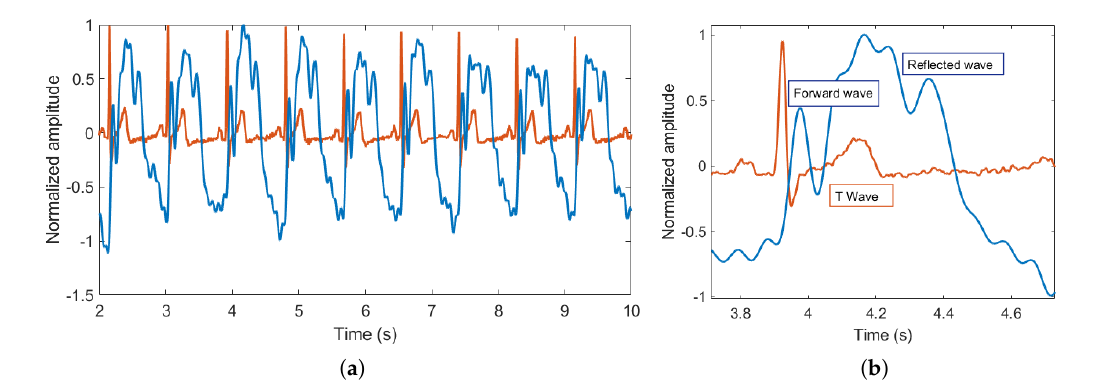
Figure 12. ( a ) Heartbeat waveform extracted from a subject holding his breath with its reference ECG, for a person with a heart rate between 70–71 beats/min. ( b ) Zoom of one pulse corresponding to the heartbeat waveform extracted with the radar and its associated